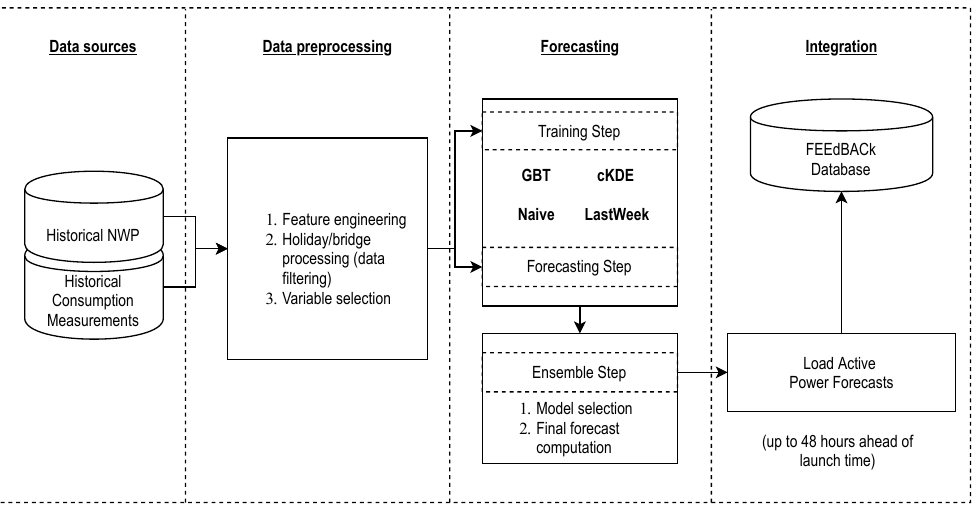
Figure 14. Block-scheme of the load forecasting